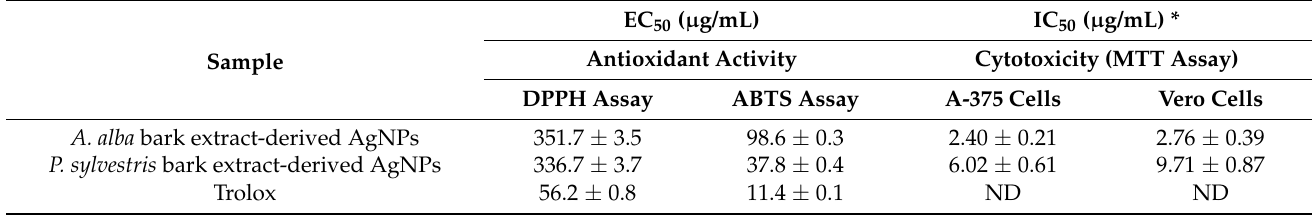
Table 1. Antioxidant and cytotoxic activity of Abies alba and Pinus sylvestris bark extract-derived AgNPs.